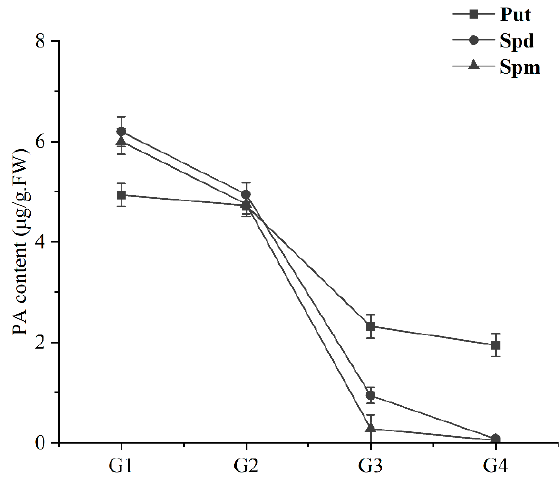
Figure 8. The PA content during fruit development of sweet cherry. 2.7. Genetic Transformation of Arabidopsis thaliana with PavCuAO4 and Detection of Free PAs in